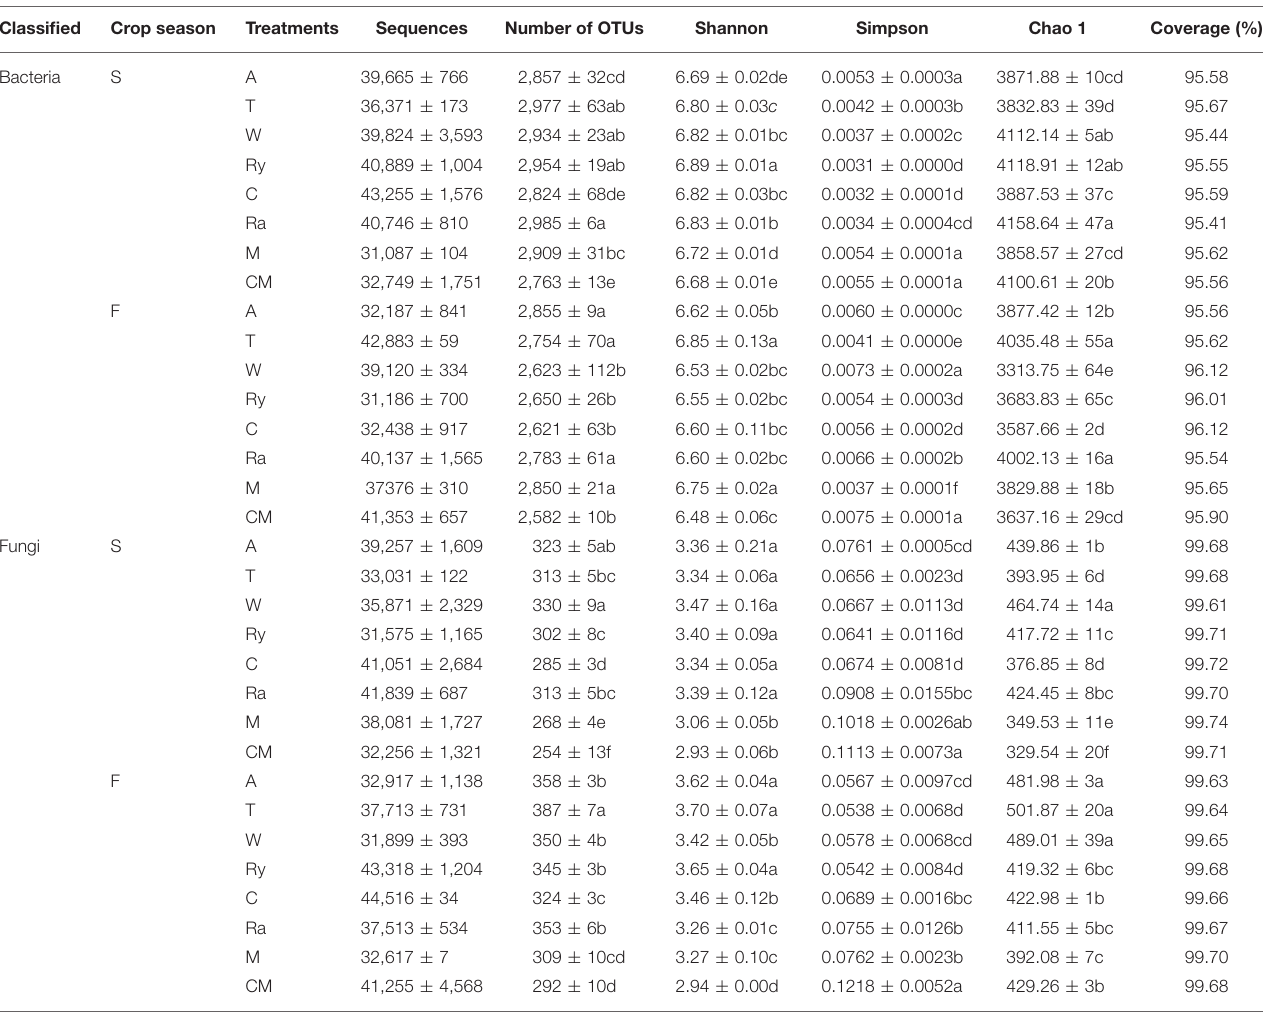
TABLE 2 | Diversity indices of soil microbial communities based on 16S rRNA and ITS genes analyzed from Illumina Miseq sequencing.